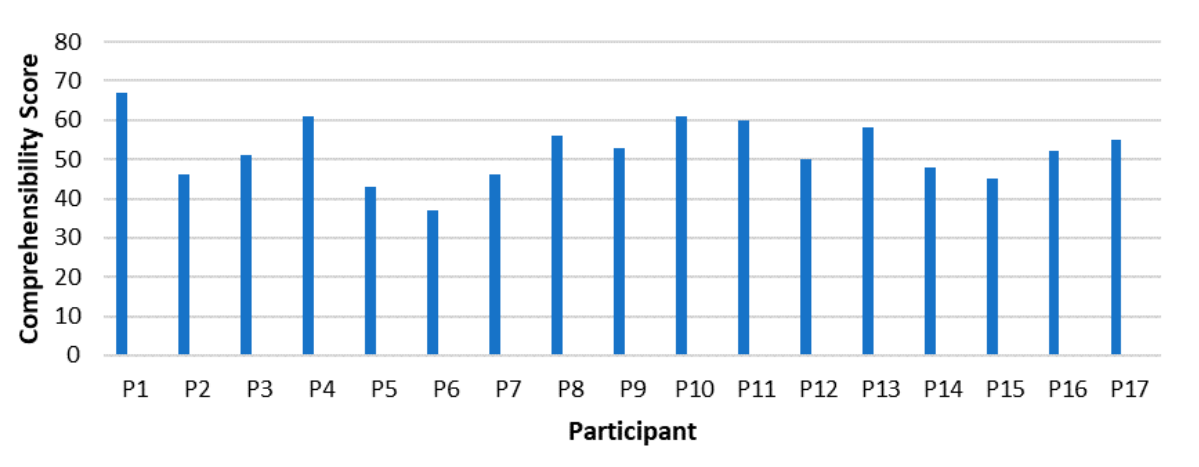
Figure 1. Comprehensibility in Managers.